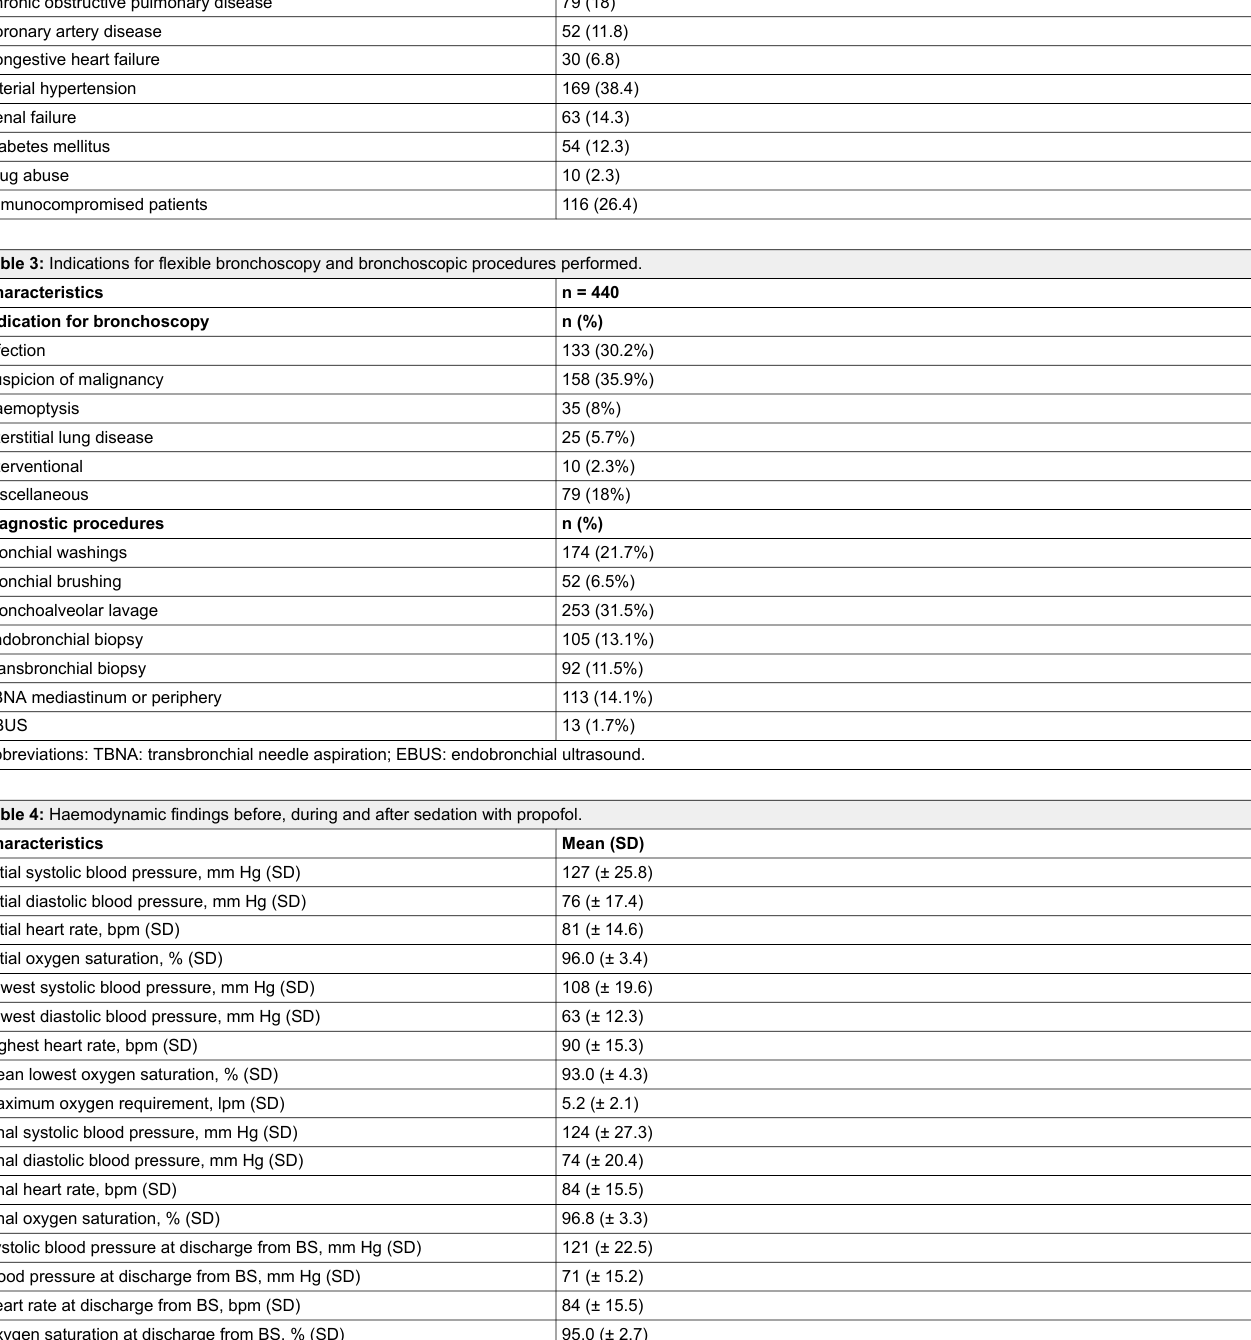
Table 2: Co-morbidities of 440 patients undergoing bronchoscopy. Characteristics, %